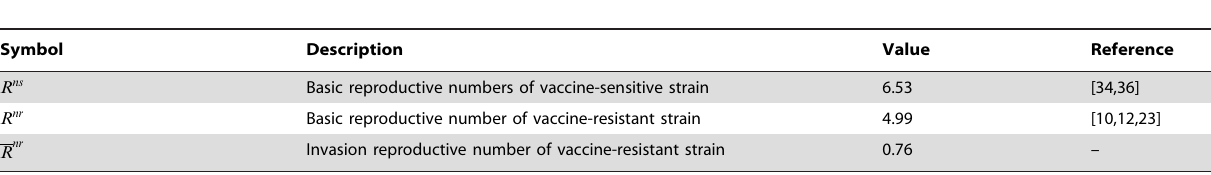
Table 2. Basic reproductive numbers and invasion reproductive numbers before the vaccination program.